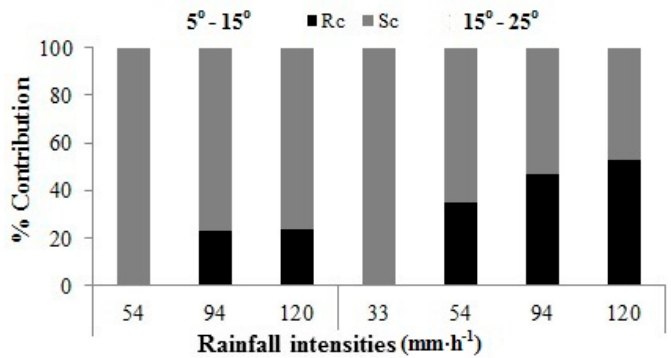
Figure 3. Rainfall (Rc) and slope (Sc) contributions for runoff losses under different rainfall intensities with an increase in slope steepness from 5° to 15° and 15° to 25° in mulched purple soil.